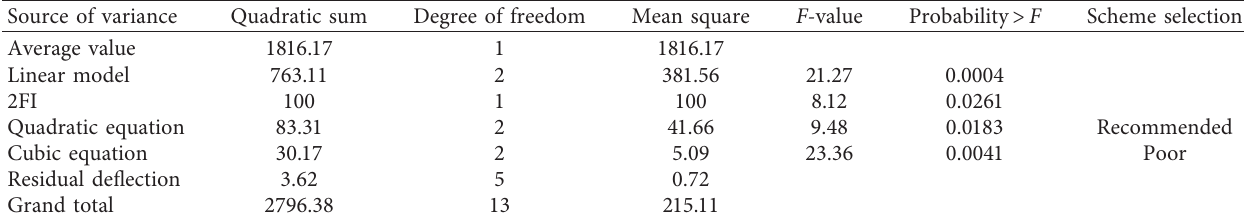
Table 2: The variance of comprehensive combustion characteristic index of different models.